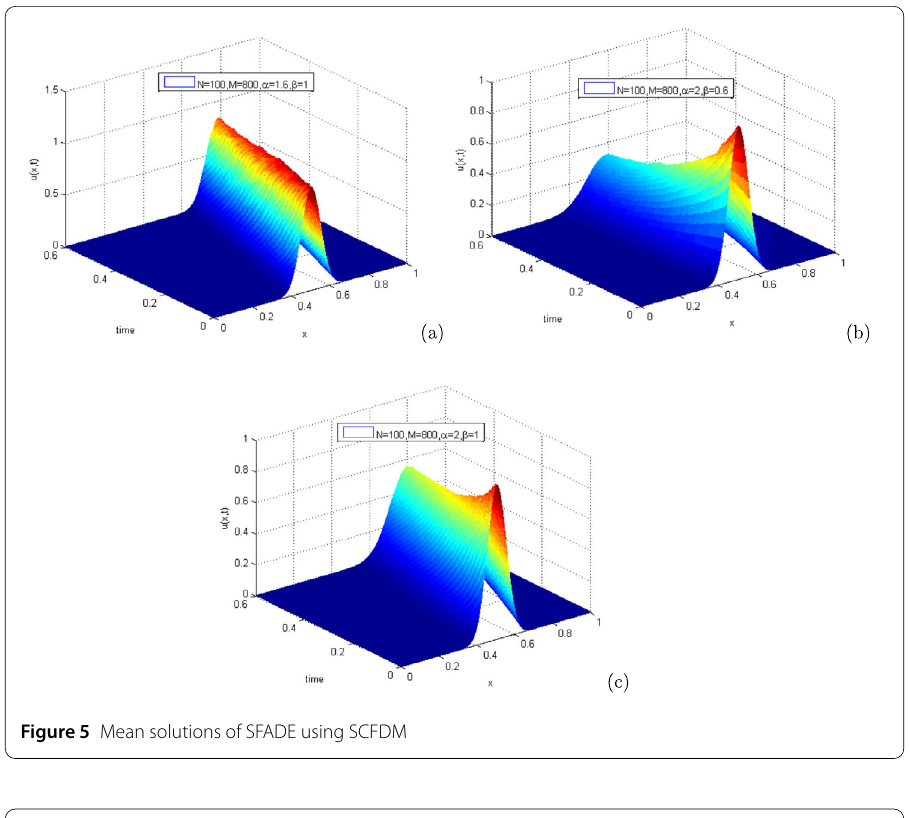
Figure 5 Mean solutions of SFADE using SCFDM